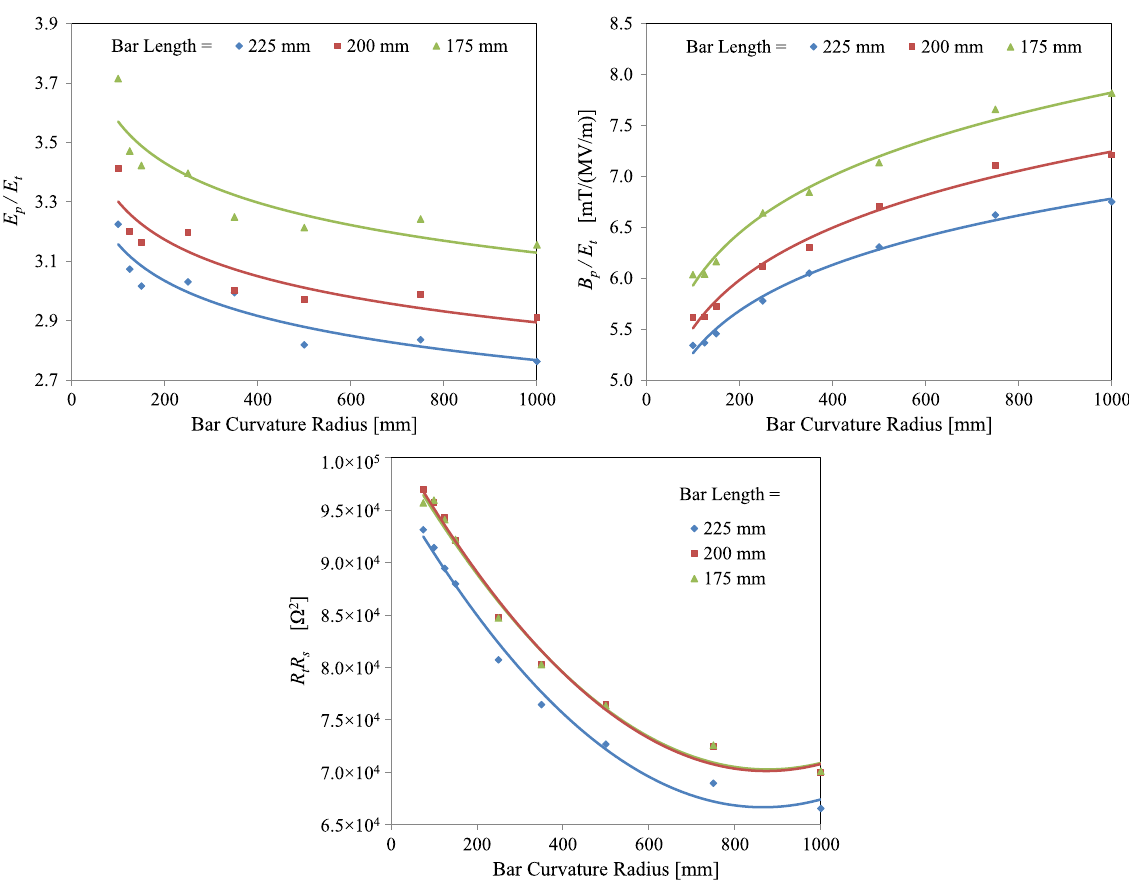
FIG. 22. Ratios of peak surface electric field ( E p ) and magnetic field ( B p ) to the transverse electric field ( E t ) and R t R s with varying radius of bar curvature for parallel bars merged onto the cavity surface [Design